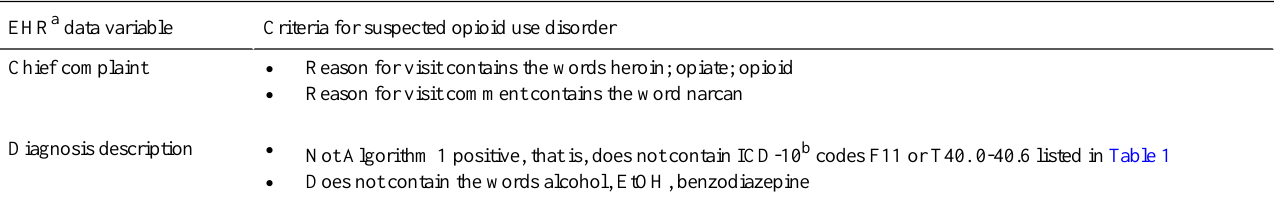
Table 2. Algorithm 2 case definition variables.